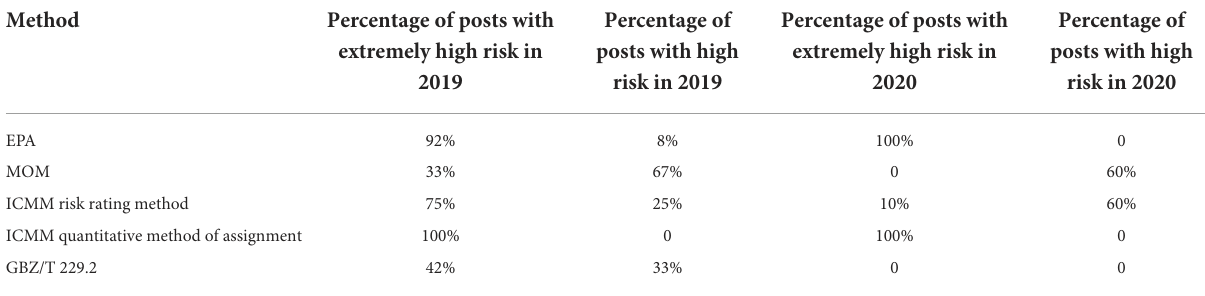
TABLE 5 Post risk distribution in 2019 and 2020.